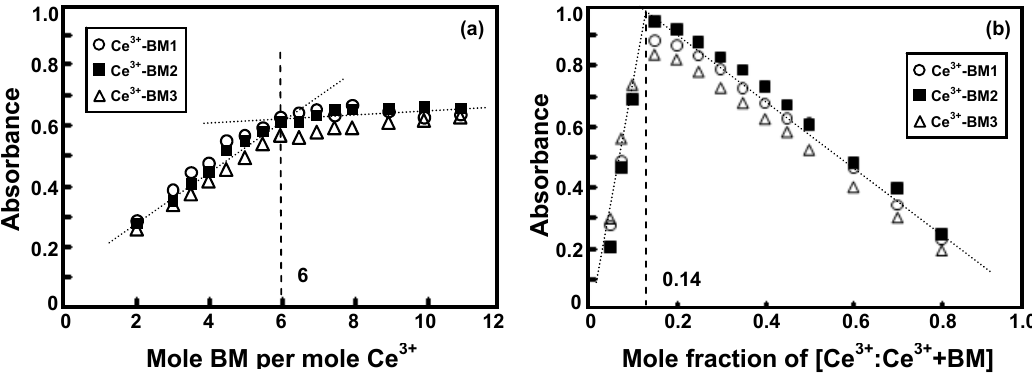
Figure 8. ( a ) Molar ratio plot and ( b ) Job’s plot of Ce(III)-benzoxazine monomer complexes in ethanolic solution.